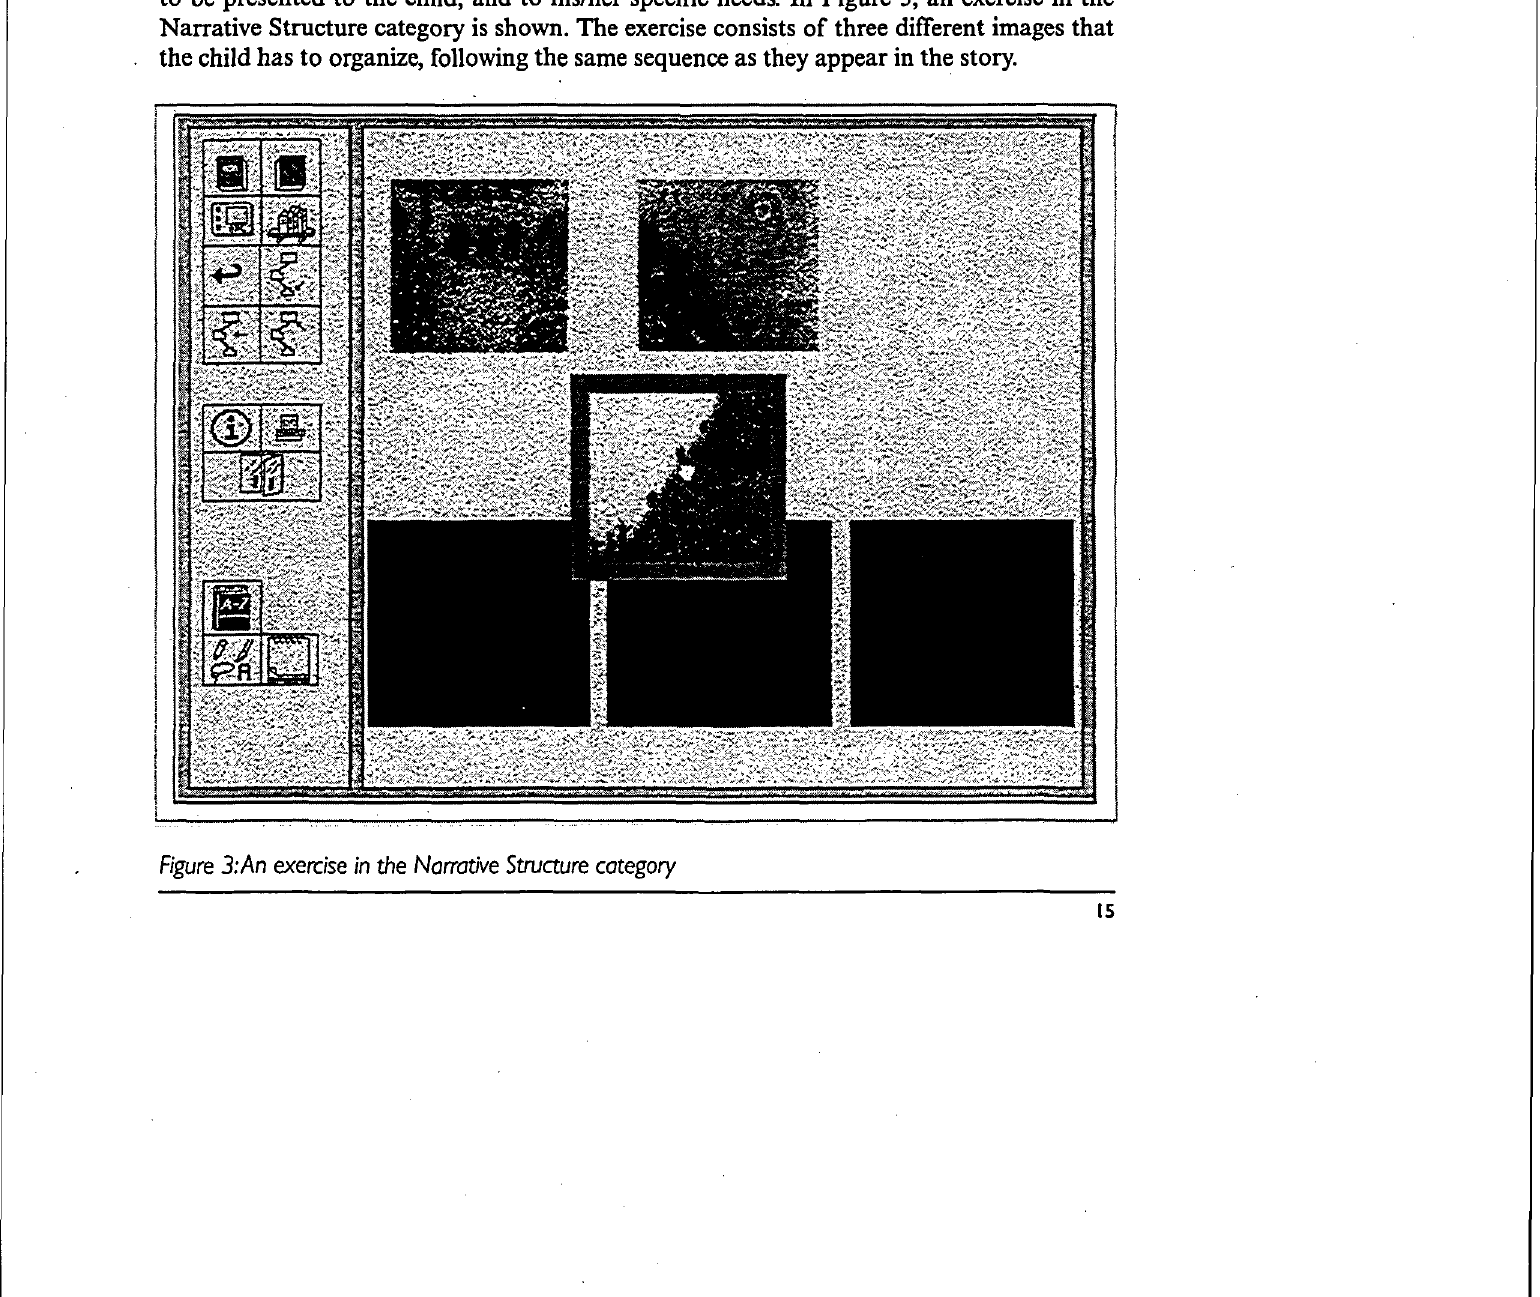
Figure 3:An exercise in the Narrative Structure